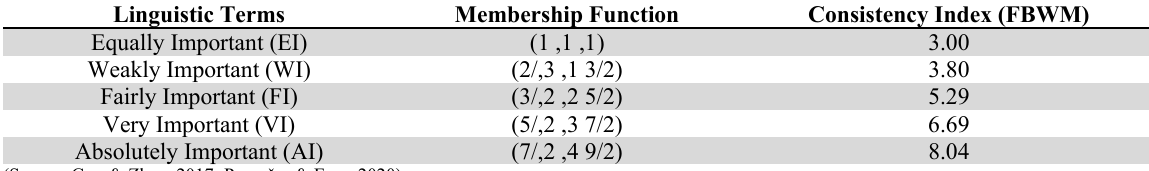
Fuzzy Linguistic Terms for